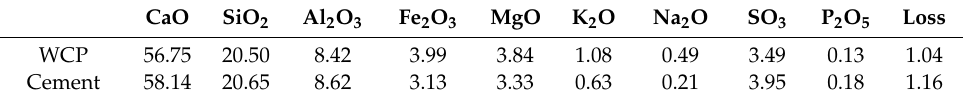
Table 1. Chemical ingredients of waste concrete powder (WCP) and cement used in the measure